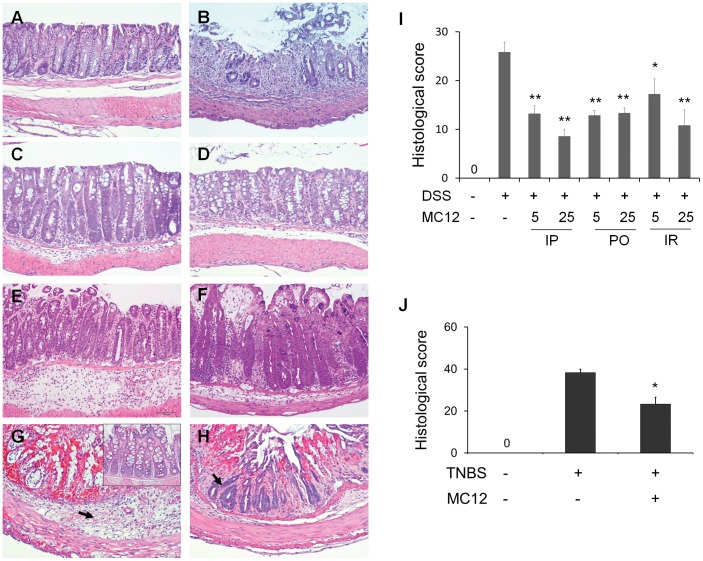
MC-12 ameliorates colitis induced by both DSS and TNBS.Paraffin sections of colonic tissues were stained with hematoxylin & eosin and their histological scores were determined as in Methods. A: Normal mucosa of the C57BL/6 mouse. B: Severe inflammation including infiltration by inflammatory cells, edema, loss of crypts and ulcerations are seen in a DSS + vehicle-treated mouse. C, D: MC-12, 5 or 25 mg/kg, IP, significantly decreased DSS-induced colonic inflammation. E: Treatment with MC-12, 25 mg/kg PO, decreased DSS-induced colonic inflammation. F: Treatment with MC-12, 25 mg/kg, IR, markedly reduced DSS-induced colitis. G: Colonic mucosa from a TNBS vehicle-treated mouse, showing severe crypt loss and inflammatory cell infiltration (arrow). Inset: normal mucosa of a healthy SJL/J mouse. H: Treatment with MC-12 25 mg/kg for 2 days decreased the inflammatory cell infiltration and crypt loss (arrow indicates remaining crypts). I, J: The histological score of the various study groups of both DSS- and TNBS-induced colitis. Values are mean ± SEM. H&E staining; magnification 100x.